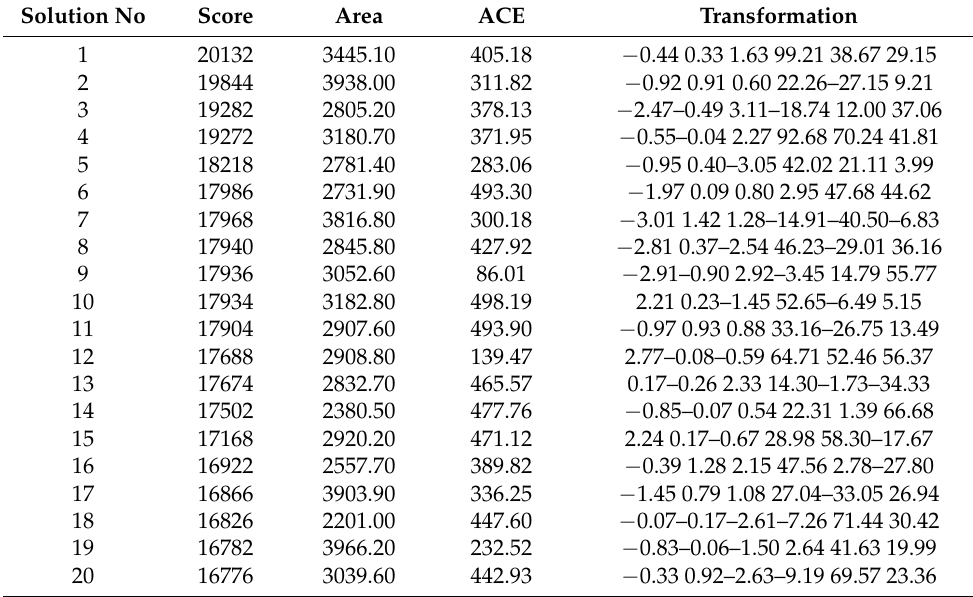
Table 7. Vaccine solutions docked for the top 20 MHC-I vaccines.